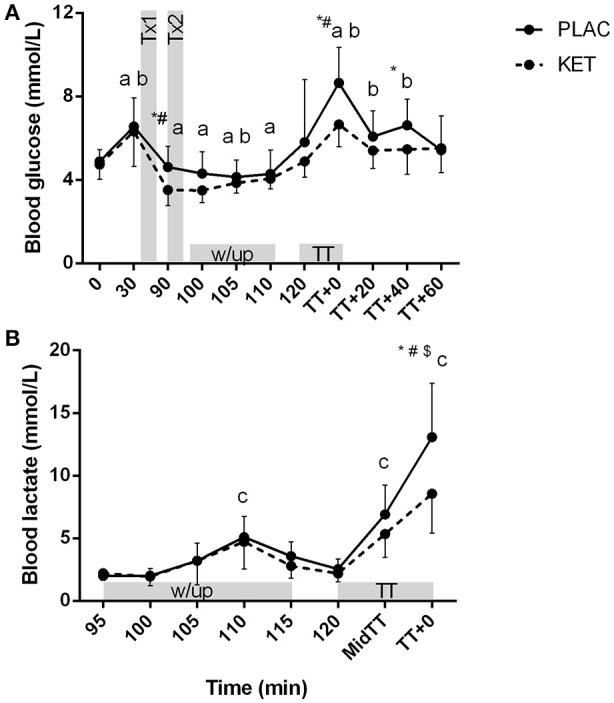
Blood glucose (A) and lactate (B) concentrations following exogenous KET or PLAC ingestion whilst completing a cycling TT. Values are mean ± SD. Tx1 and Tx2 refer to dose one and two of KET or PLAC drink. *KET different to PLAC at time point; a different to t = 120 min within KET; b different to t = 120 min within PLAC; c different to 95 min within and PLAC; #different to all other time points within PLAC; $different to all other time points within KET.